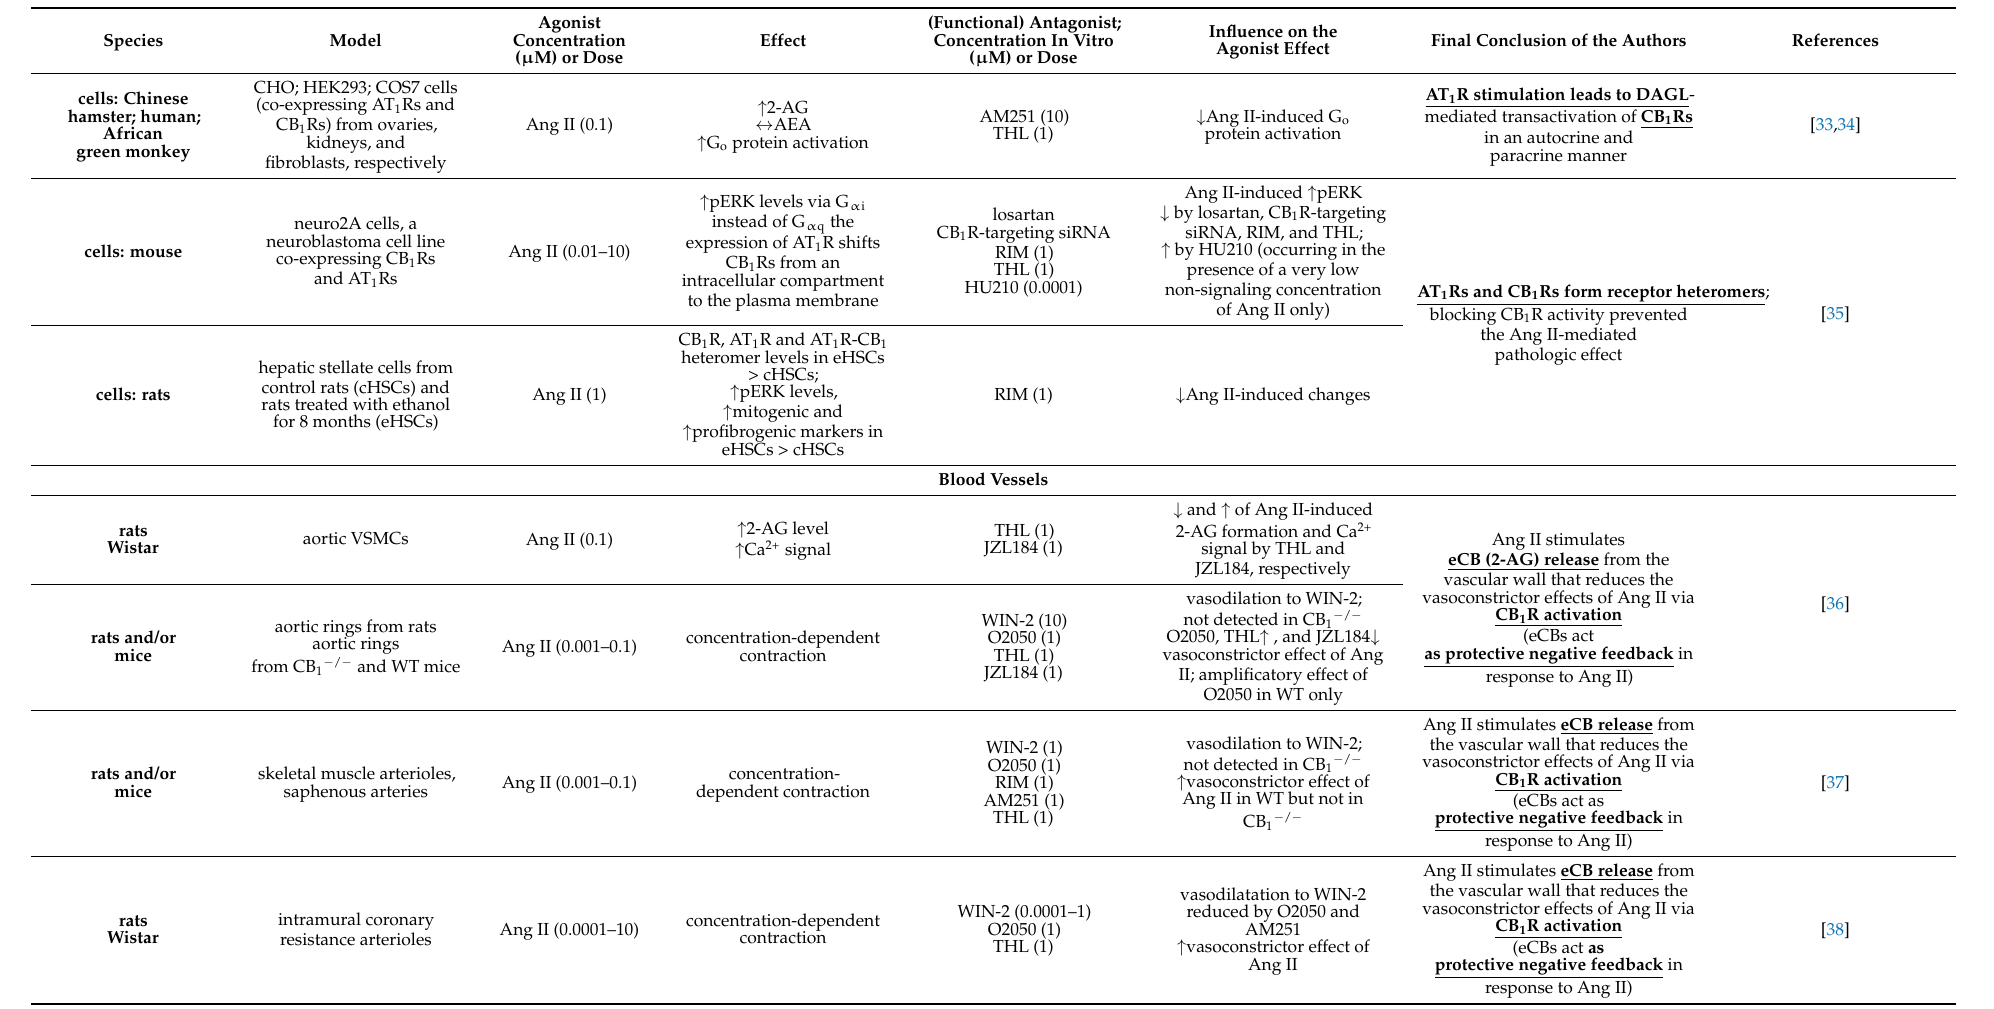
Table 2. Examples of the cross-talk between the (endo)cannabinoid and renin-angiotensin